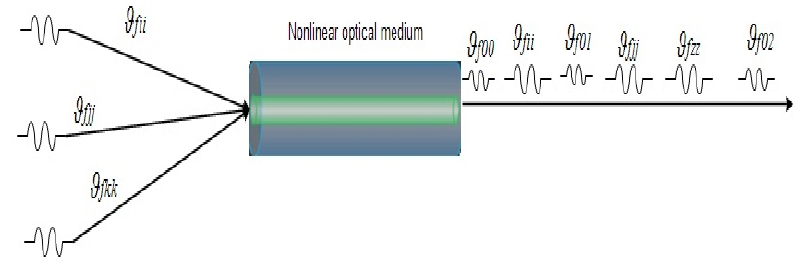
Figure 3. Induction of unwanted frequencies due to four wave mixing (FWM)